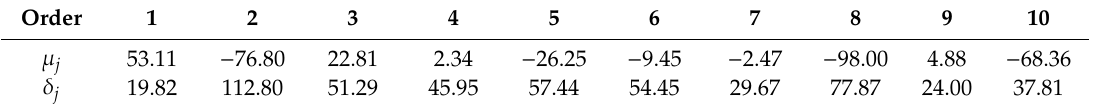
Table 2. Parameters of curve similarity model (CSM) for o ff -ground status.